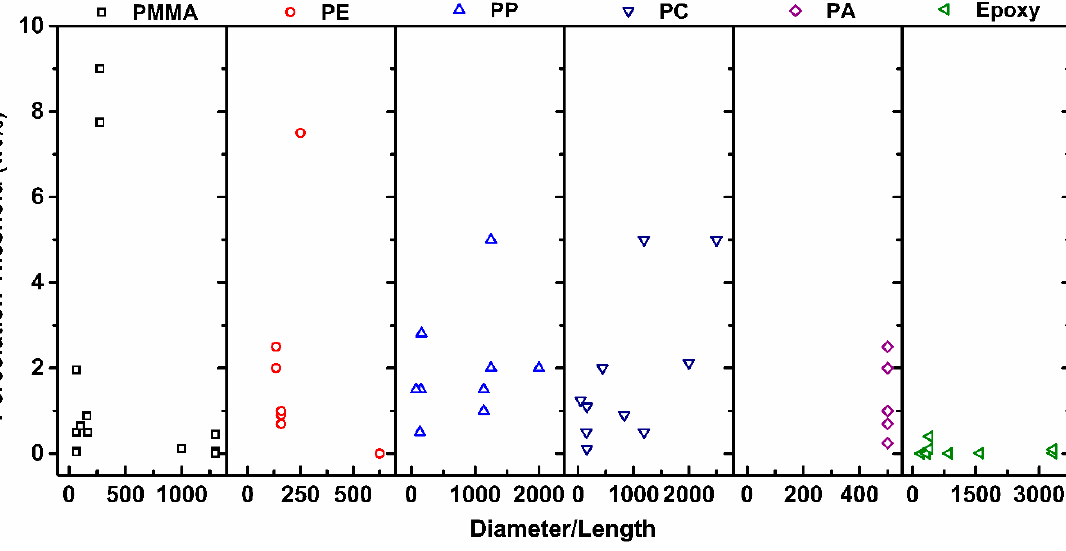
Figure 25. Variation of percolation threshold with the aspect ratio of CNTs used in different polymer matrix composites [1,3,9,15,17–57]. For more details, see Table S1 in the supplementary file.